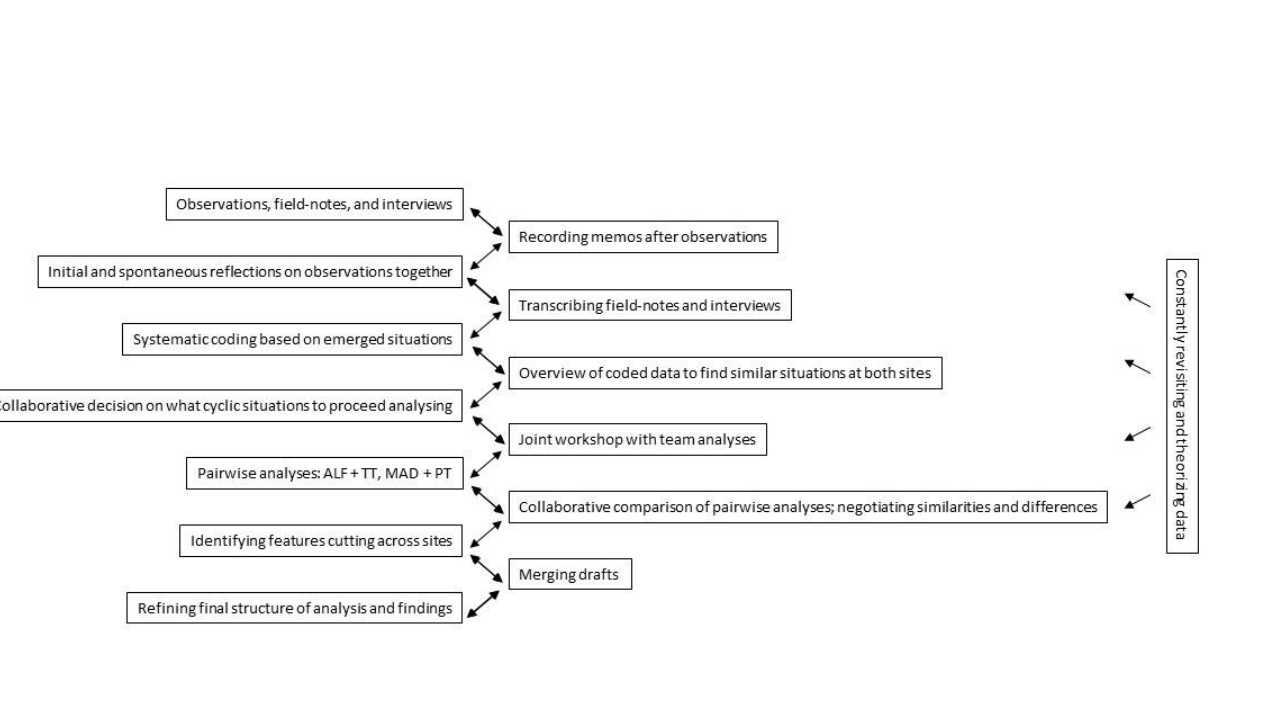
Figure 1. The iterative process of analysis applied in this